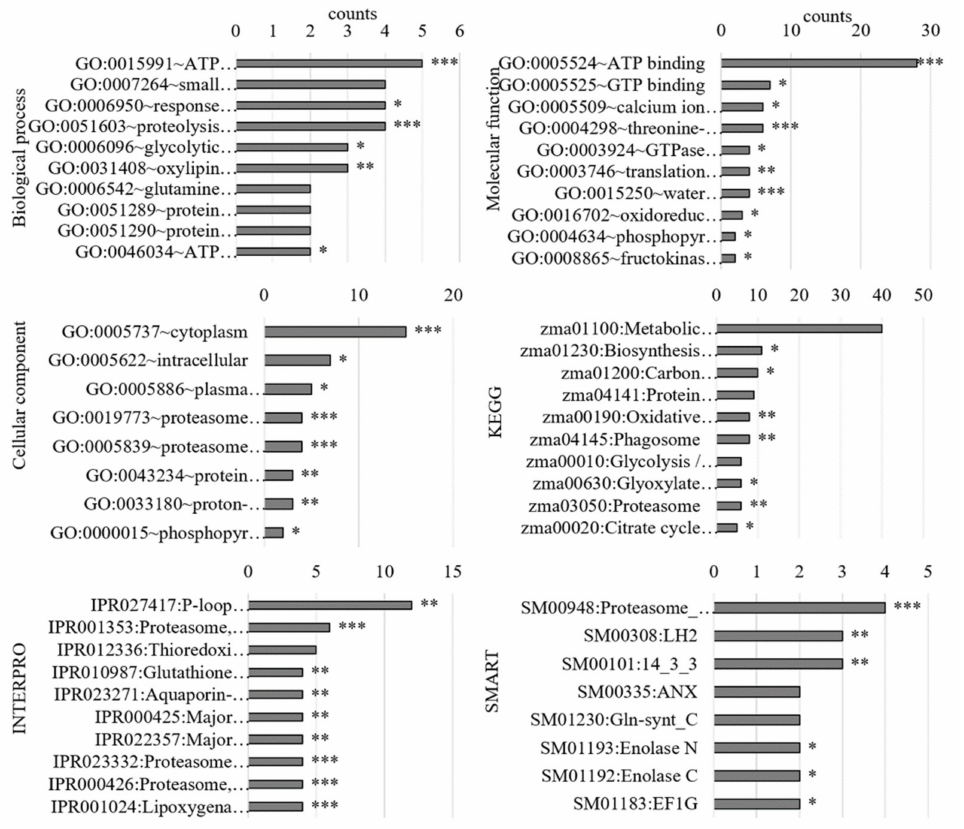
Figure 8. Gene ontology analyses of PM-bound proteins altered by hypoxia. Plasma membrane- bound proteins that were significantly altered by 24 h of hypoxia were determined by mass spectrom- etry (shotgun). Using DAVID, gene ontology (GO) enrichment analyses were performed. The top five GO terms and the corresponding number of genes are shown in the graph. Asterisks indicate p -values ( p < 0.05 *, p < 0.01 **, p < 0.001 ***). ANX, annexin repeats; Proteasome_A_N,